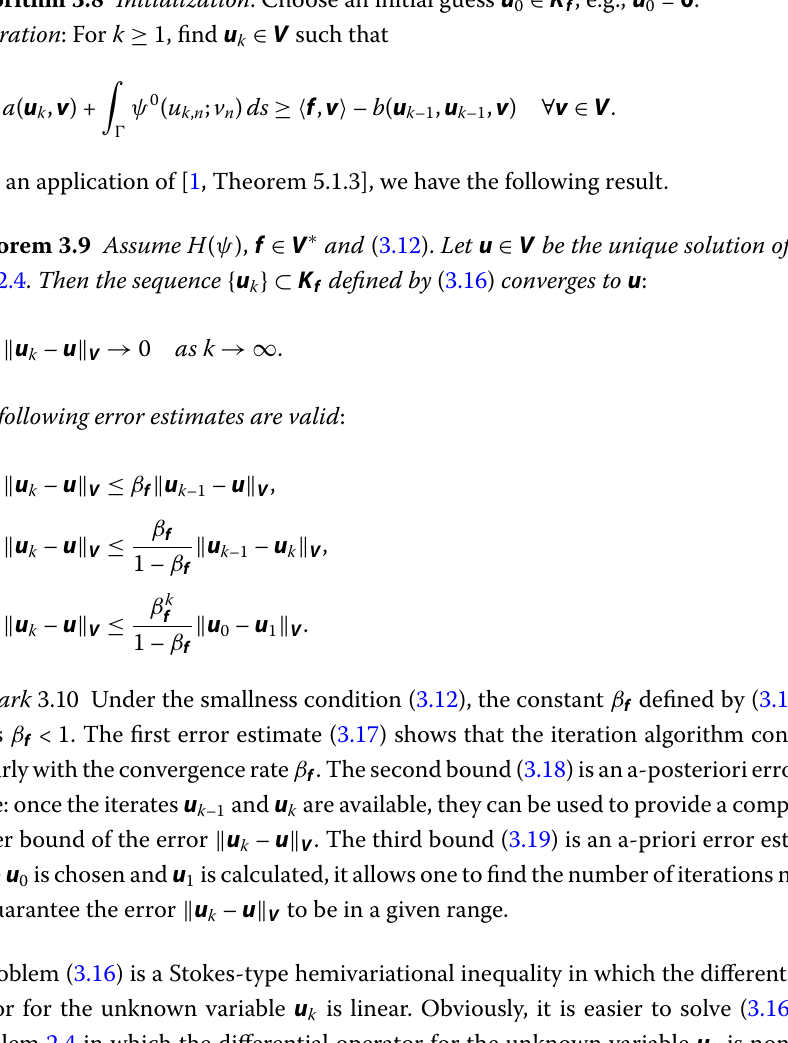
Algorithm 3.8 Initialization : Choose an initial guess u 0 ∈ K f , e.g., u 0 = 0